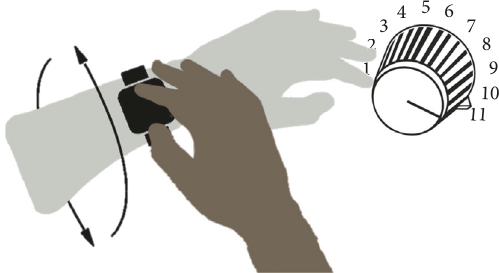
Figure 2: Conceptual picture of the wrist-twist